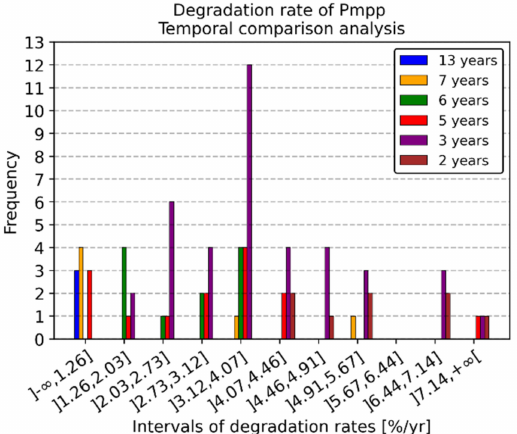
Figure 12. Temporal analysis of the degradation rate of the maximum power point.